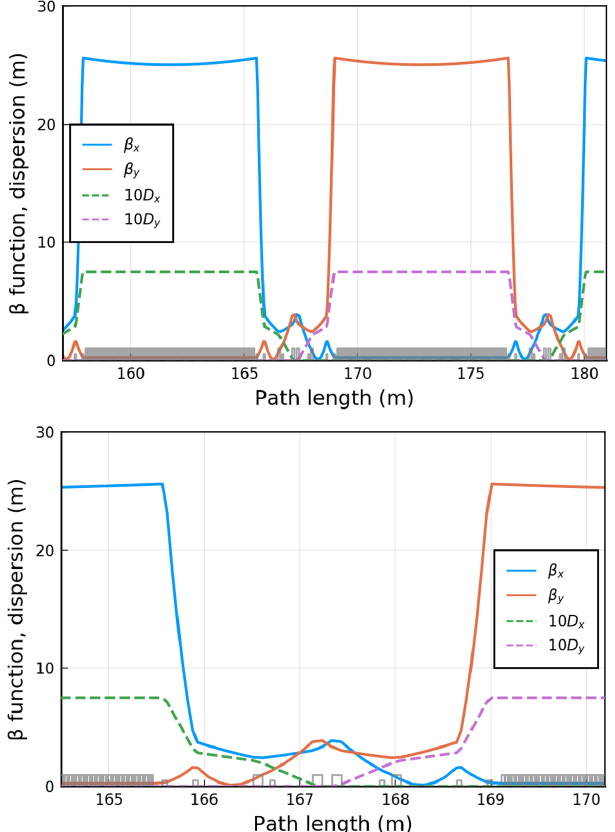
FIG. 4. Twiss functions in the wiggler and in the transition between wigglers.